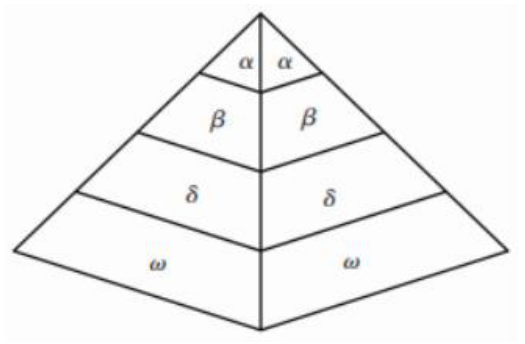
Figure 1. Grey wolf class system.